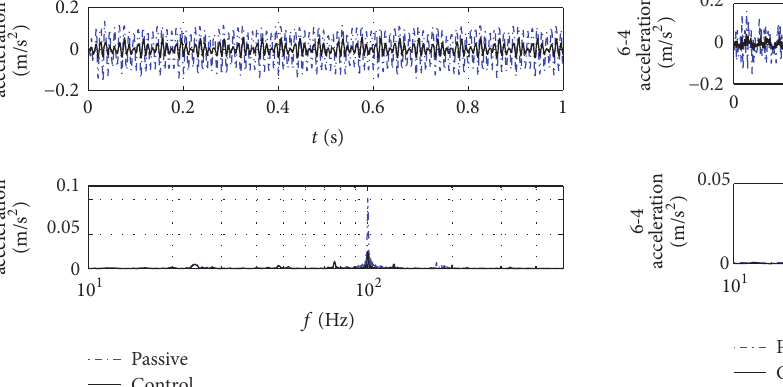
Figure 26: Comparison time-frequency domain curves of acceler- ation response of position 6-4 on the experimental platform before and after being